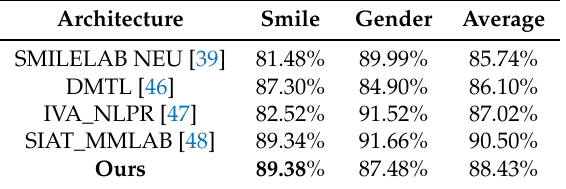
Table 2. Performance comparison for smile and gender prediction on FotW datasets.